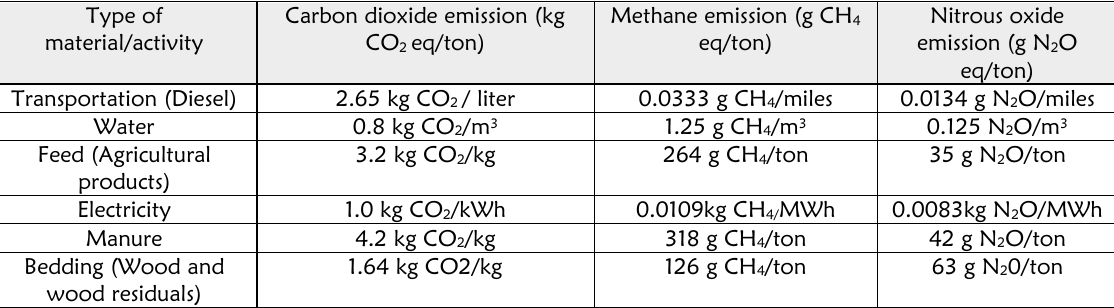
Table 4: Greenhouse gas emission factor (Environmental Protection Agency, 2015)